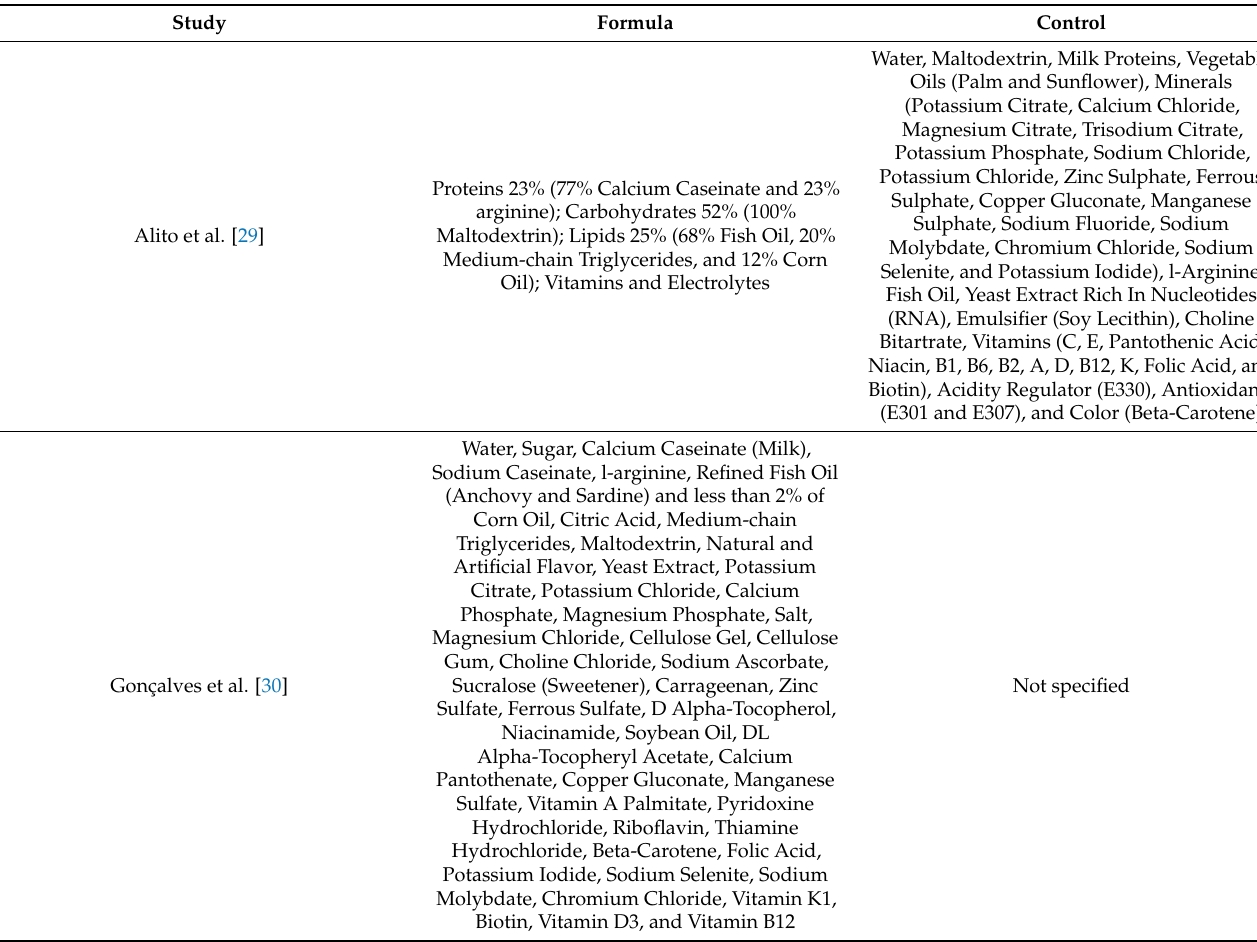
Table 8. Immunonutrition formula